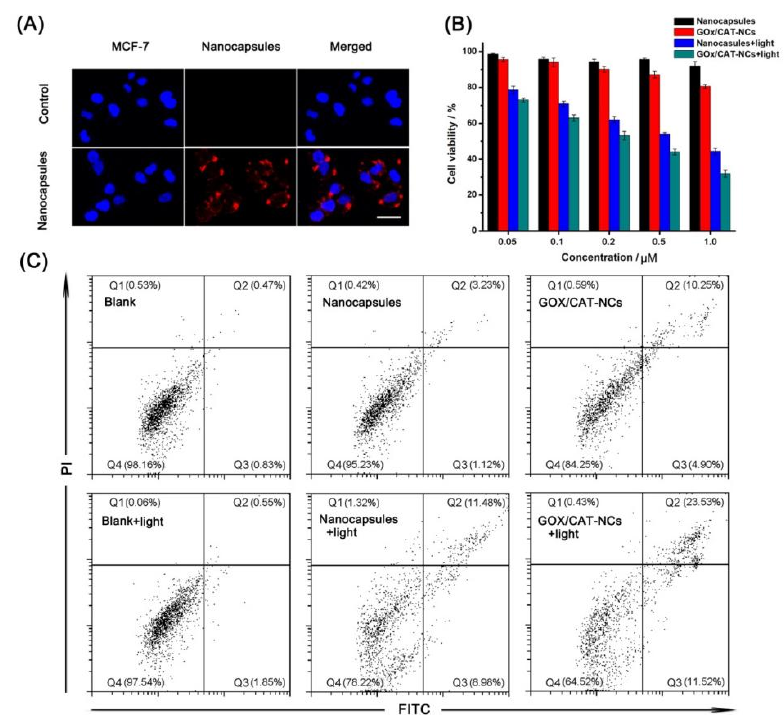
Figure 4. ( A ) The CLSM images of untreated MCF-7 cells and MCF-7 cells after incubation with nanocapsules, cell nuclei stained with Hoechst (blue channel). The scale bar is 50 μ m. ( B ) MTT assay of the MCF-7 cells with various treatments. ( C ) Flow cytometry analysis of the MCF-7 cells with various treatments.